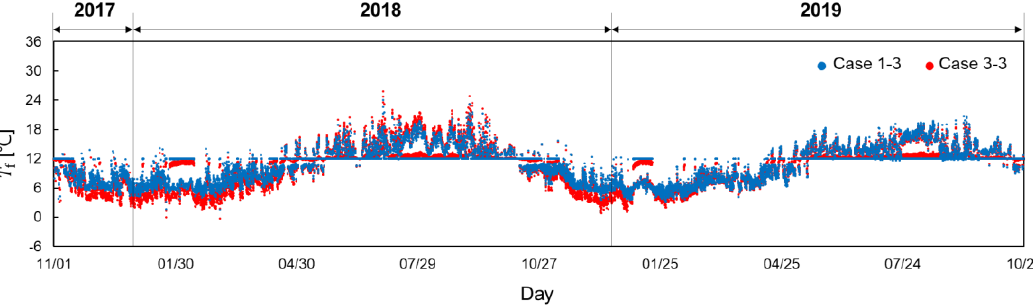
Figure 17. Average temperature variation of the circulating fluid; comparison between the multilayer and single layer for the design parameters.